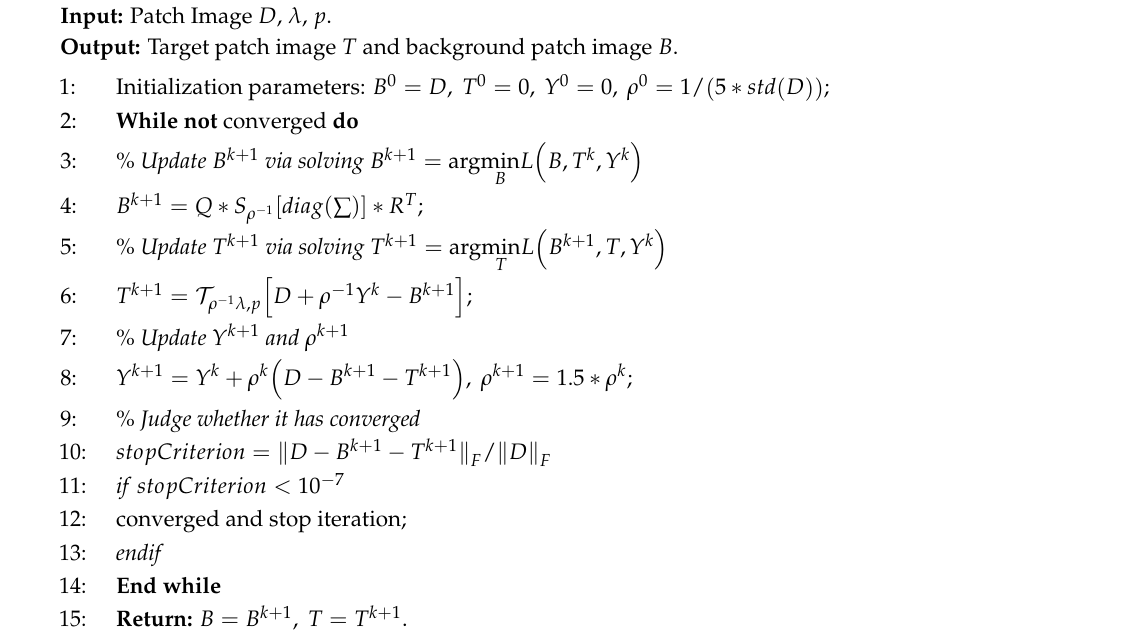
Algorithm 1 Solving the objective function of NOLC